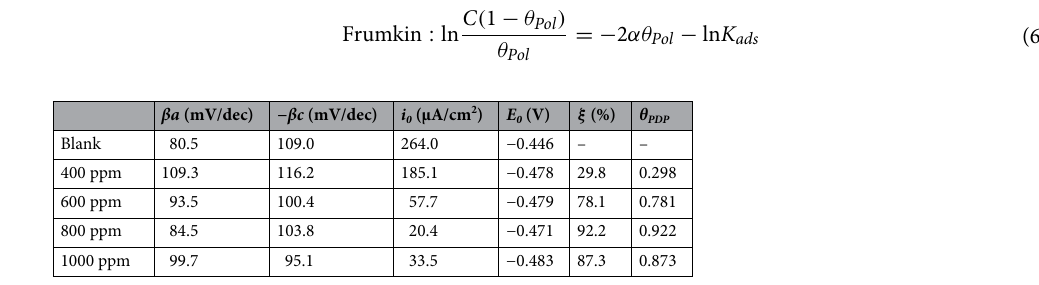
Table 2. Parameters acquired from polarization